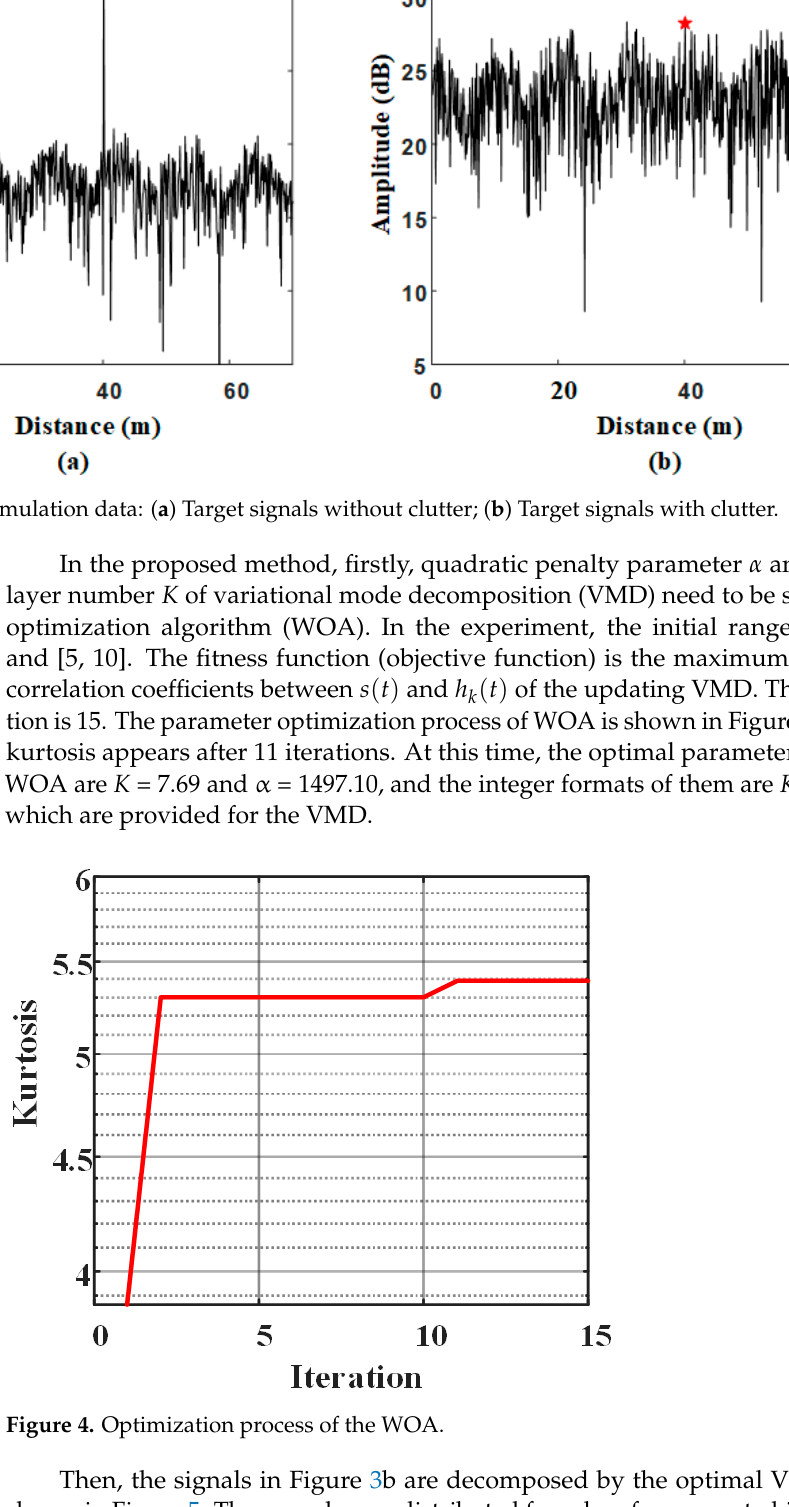
Figure 5. Signal decomposition using the optimal VMD.